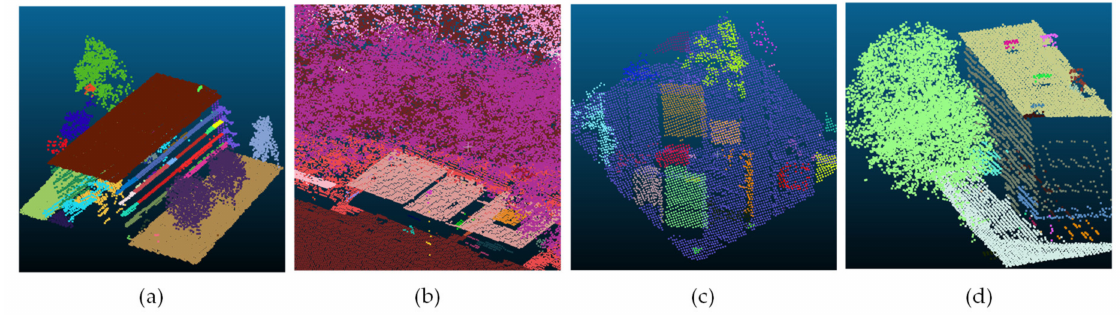
Figure 4. Unsupervised segmentation results. ( a ) Segmentation result on unlabeled area caused by datasets registration problem; ( b ) Segmentation result on mislabeled tree points as they are in the building polygon; ( c ) Segmentation result on unlabeled building points caused by missing building polygons; ( d ) Segmentation result on unlabeled tree points caused by missing vegetation